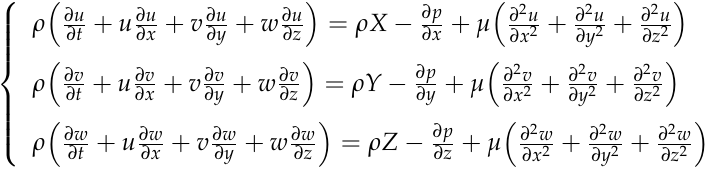
Internal diameter of the radial groove/D 2